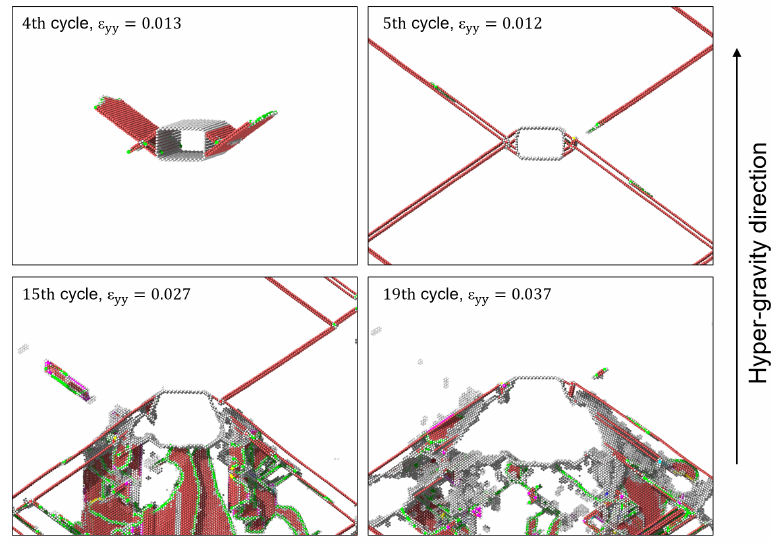
greater the gravity, and the greater the crack propagation rate in the later stage.